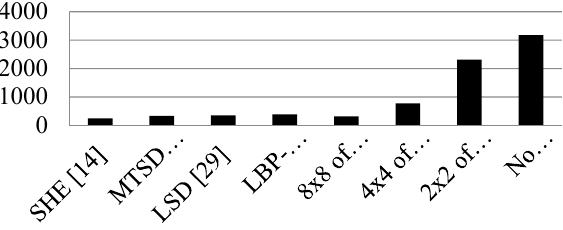
Figure 6. Time consumption of each algorithm to perform a complete retrieval procedure on Corel-1k.